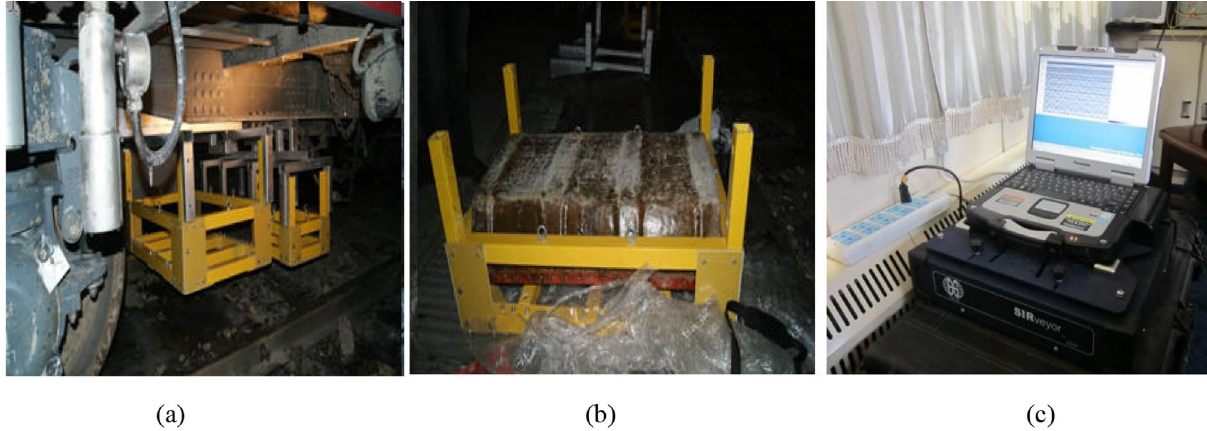
Figure 3. The GPR and its suspension system. ( a ) suspension system of radar antenna for track inspection train, ( b ) photo for fixed radar antenna, ( c ) SIR-20 ground penetrating radar (Fig. 3c) and the working parameters of the ground-penetrating radar are set as follows: sampling interval is 5 cm; the maximum depth reaches 8 m; depth resolution is up to 0.2 m; sampling rate is set to 100 scans −1 , and a